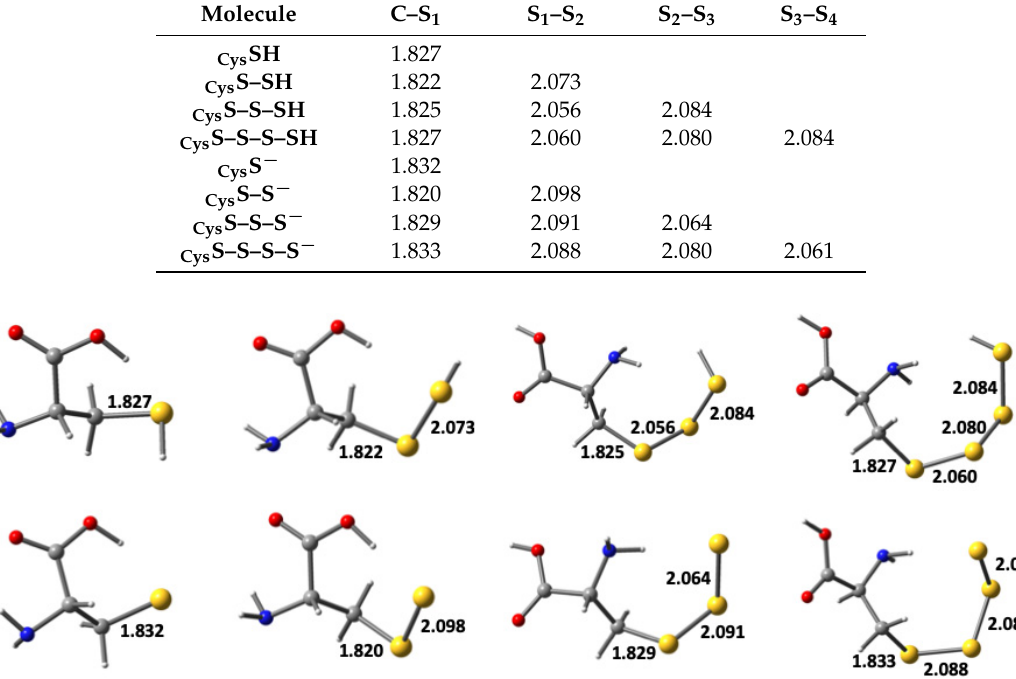
Figure 1. Optimized structures (with C–S and S–S bond lengths given in ångstroms (Å)) obtained at the ω B97XD/6-311G(2d,p) level of theory for neutral cysteine and its polysulfide (CysS–S n H n = 1–3) derivatives (top row), and their corresponding anionic deprotonated derivatives (CysS–S n − n = 0–3; bottom row).